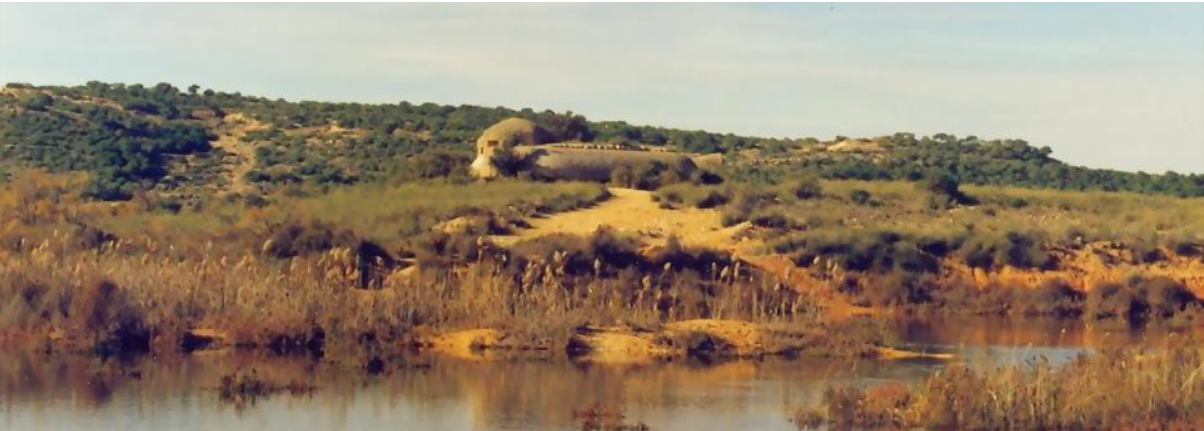
Figure 1. Main bunker (CG-BK04.elc), Clot de Galvany enclave (Elche, España), in the middle of the lagoon (photo: